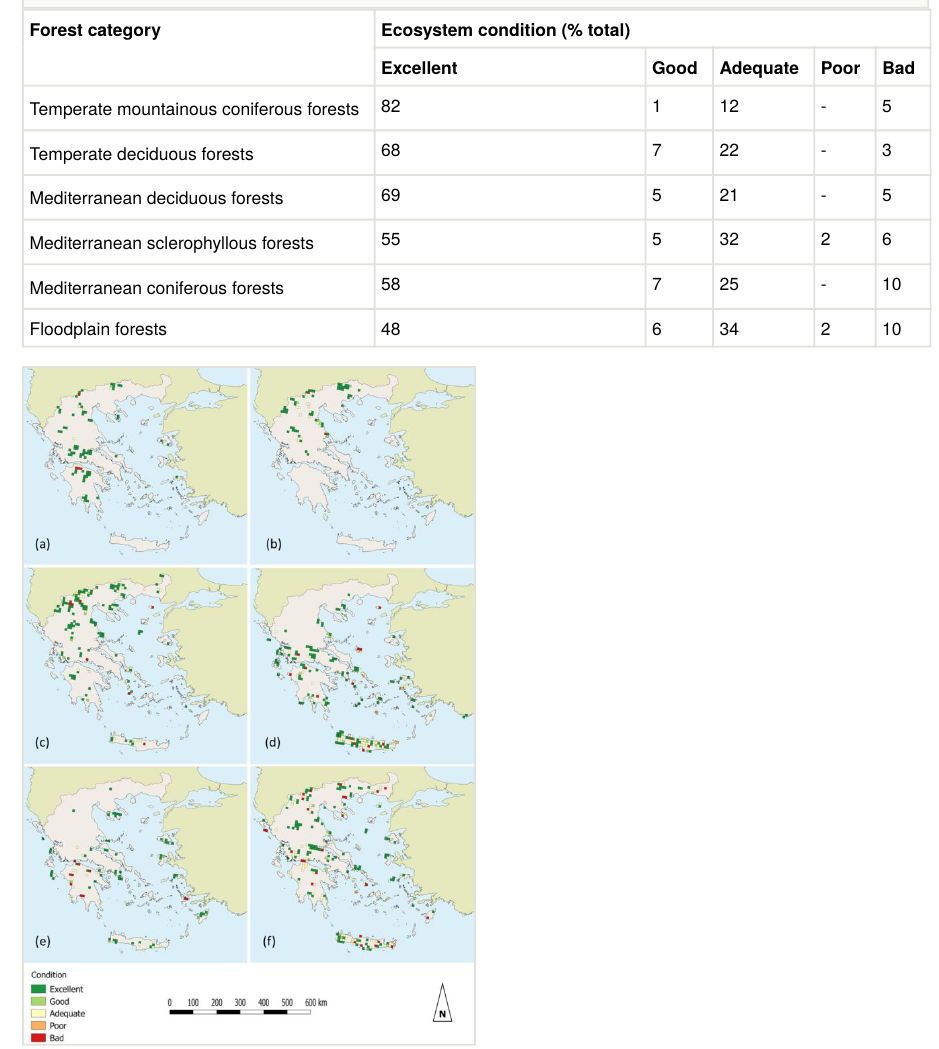
Forest categories condition mapping based on the EEA 10 km grid cell analysis: (a) Temperate mountainous coniferous forests, (b) Temperate deciduous forests, (c) Mediterranean deciduous forests, (d) Mediterranean sclerophyllous forests, (e) Mediterranean coniferous forests and (f) Floodplain